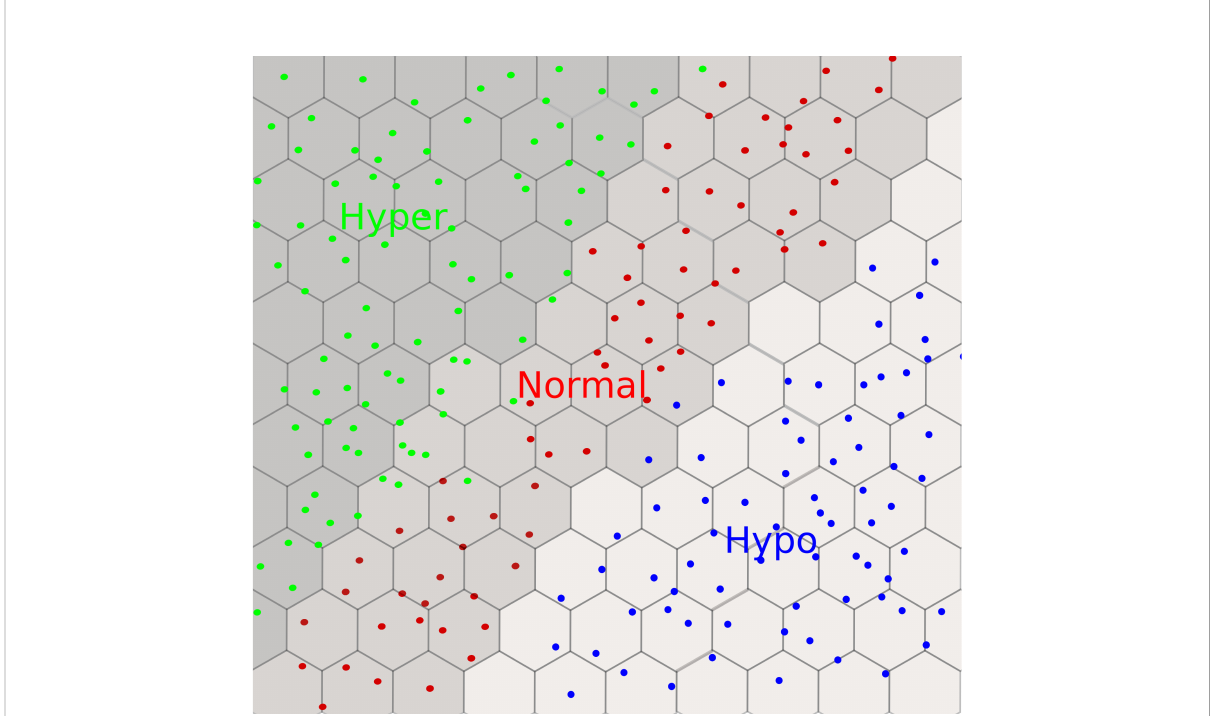
FIGURE 10 An example of a self-organizing map with a 2D hexagonal grid for thyroid dysfunction classi fi cation. We observe three clusters: hyper in green, hypo in blue, and normal in red. Each dot can be mapped to the input subject using the coordinates of the winner nodes on the